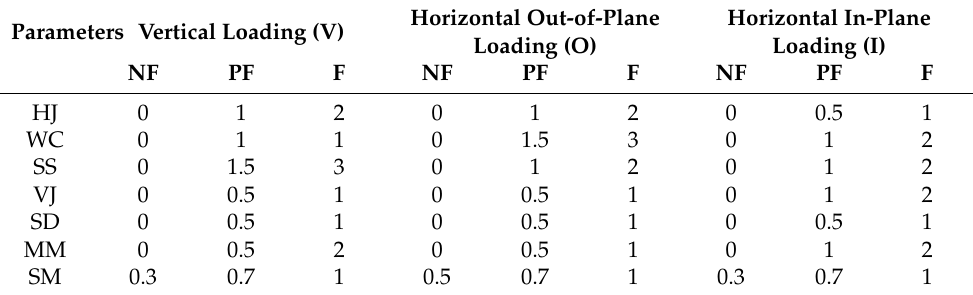
Table 2. Numerical values of the seven parameters for the calculation of the MQI. Parameters Vertical Loading (V)